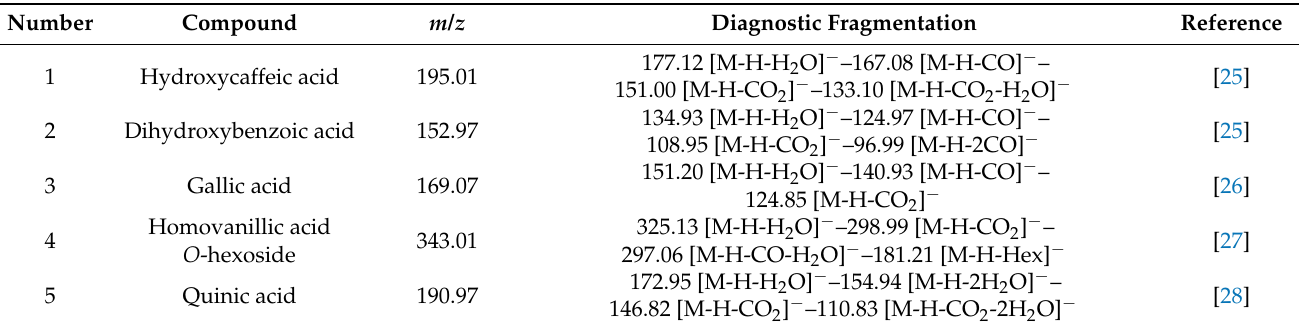
Table 1. Polyphenolic composition of thinned nectarines extracts determined by HPLC-HESI- MS/MS